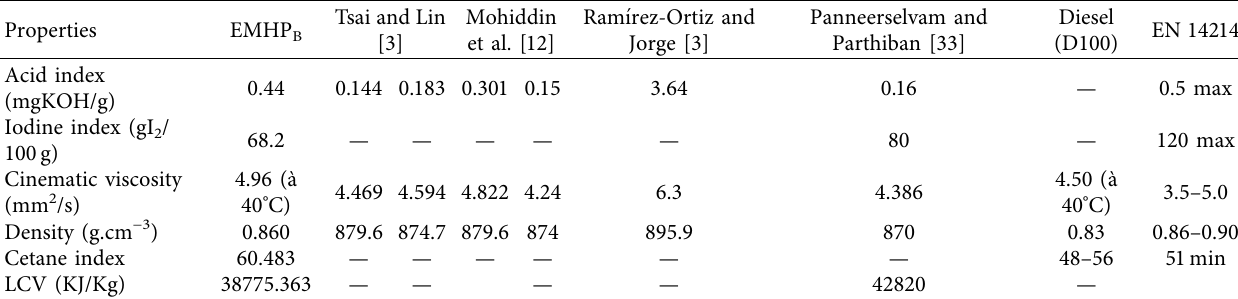
Table 6: Physical-chemical properties of chicken fat waste methyl ester.